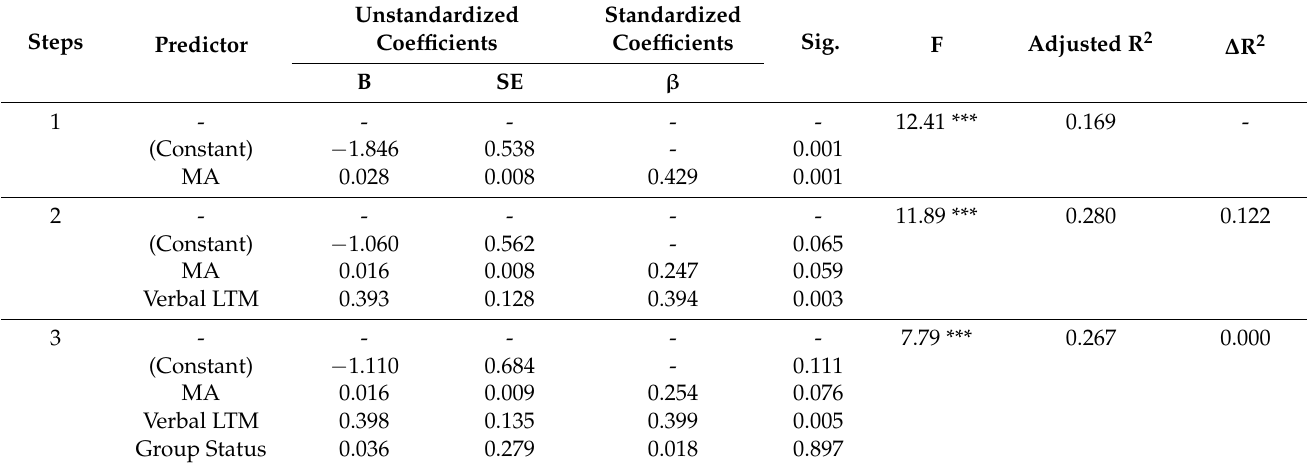
Figure 3. Scatterplot of everyday memory as a function of verbal LTM. Table 7. Regression Results where everyday memory is the